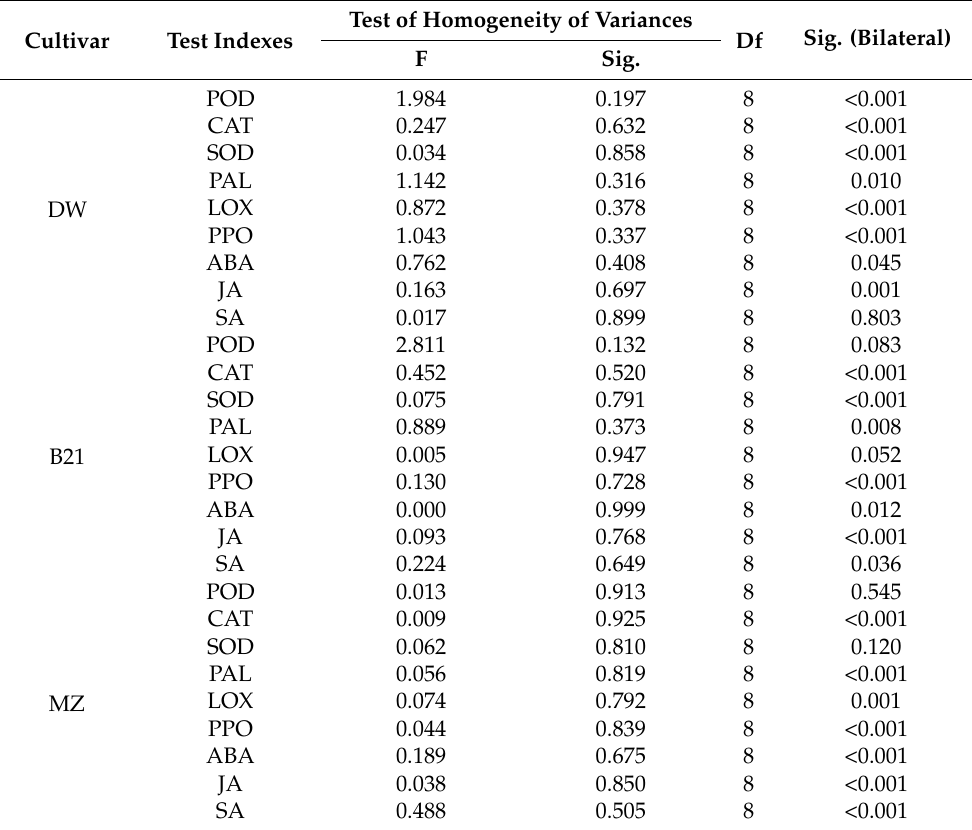
Table 5. Independent sample t -test of defense enzyme activity and hormone content of different hazel cultivars before and after chewing by C.